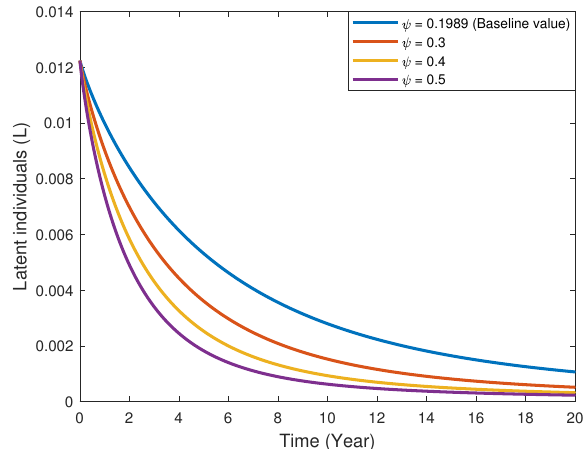
Figure 18. Behavior of L class for different ψ values.